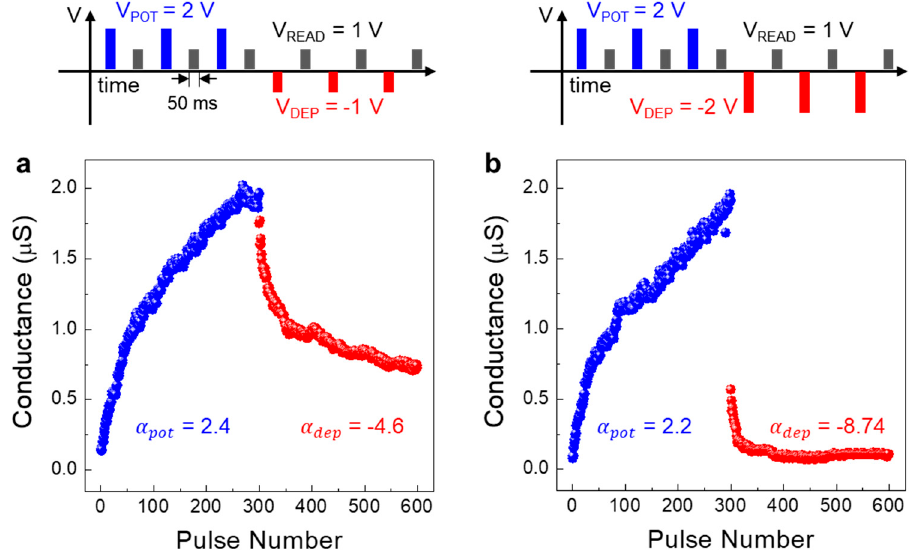
Figure 4. The weight update characteristics (conductance vs. number of pulse) of memristors with different depression pulse voltage ( a ) “A” pulse train condition ( V POT = +2 V, V DEP = − 1 V), and ( b ) “B” pulse train condition ( V POT = +2 V, V DEP = − 2 V).